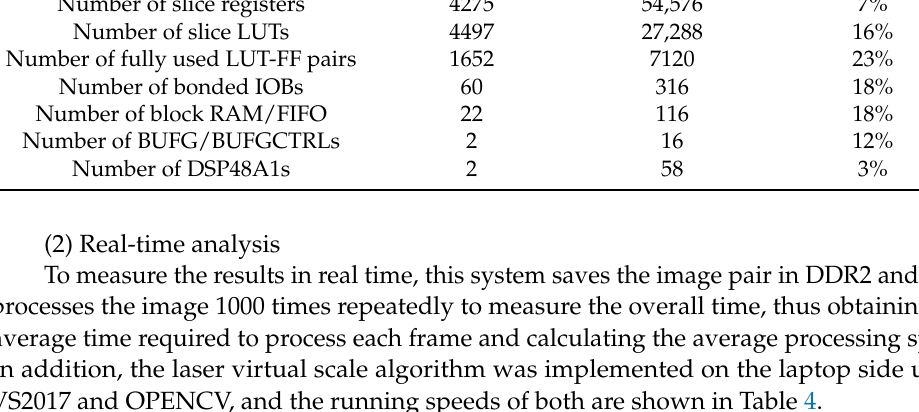
Table 3. Device utilization summary. Logic Utilization Used Available Utilization